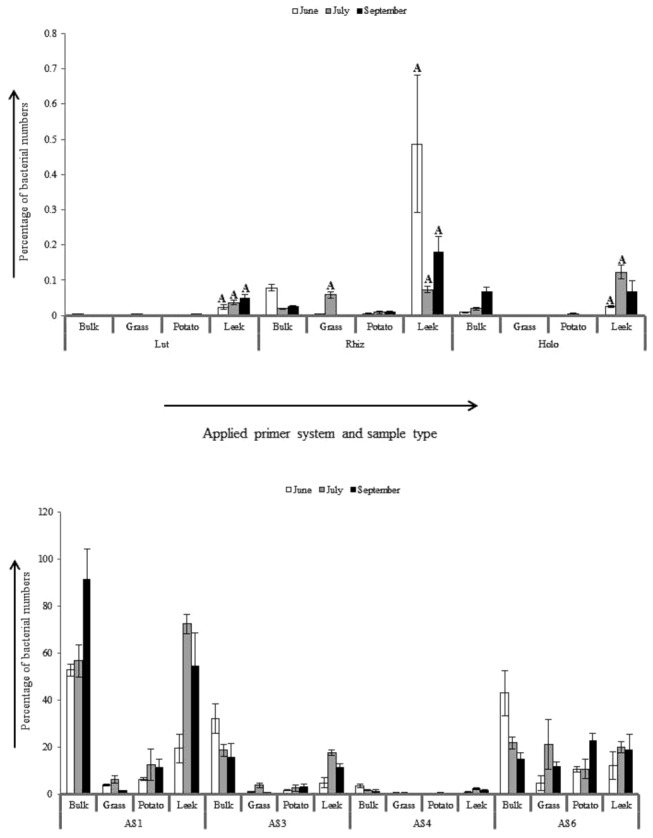
Luteolibacter, Candidatus genus Rhizospheria, subdivisions 1, 3, 4, 6 acidobacteria and holophaga as percentage of total bacteria in grass, potato and leek rhizospheres and bulk soil.Bars marked with ‘A’ indicate significant higher fraction than in corresponding bulk soil.Lut, Luteolibacter; Rhiz, Candidatus genus Rhizospheria; AS1, AS3, AS4, AS6, respectively, subdivision 1, 3, 4, 6 acidobacteria; Holo, holophaga. Bars on top of columns represent standard errors of means.